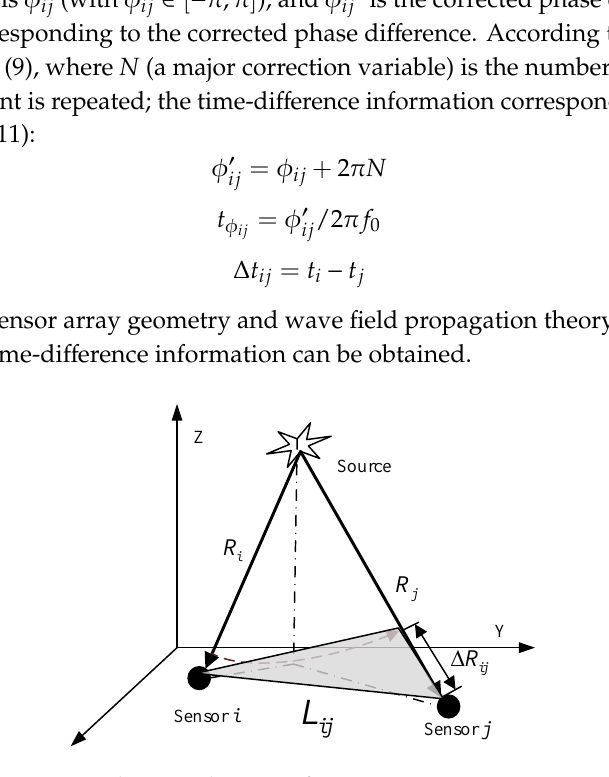
Figure 6. Schematic diagram of sensor geometry constraints.